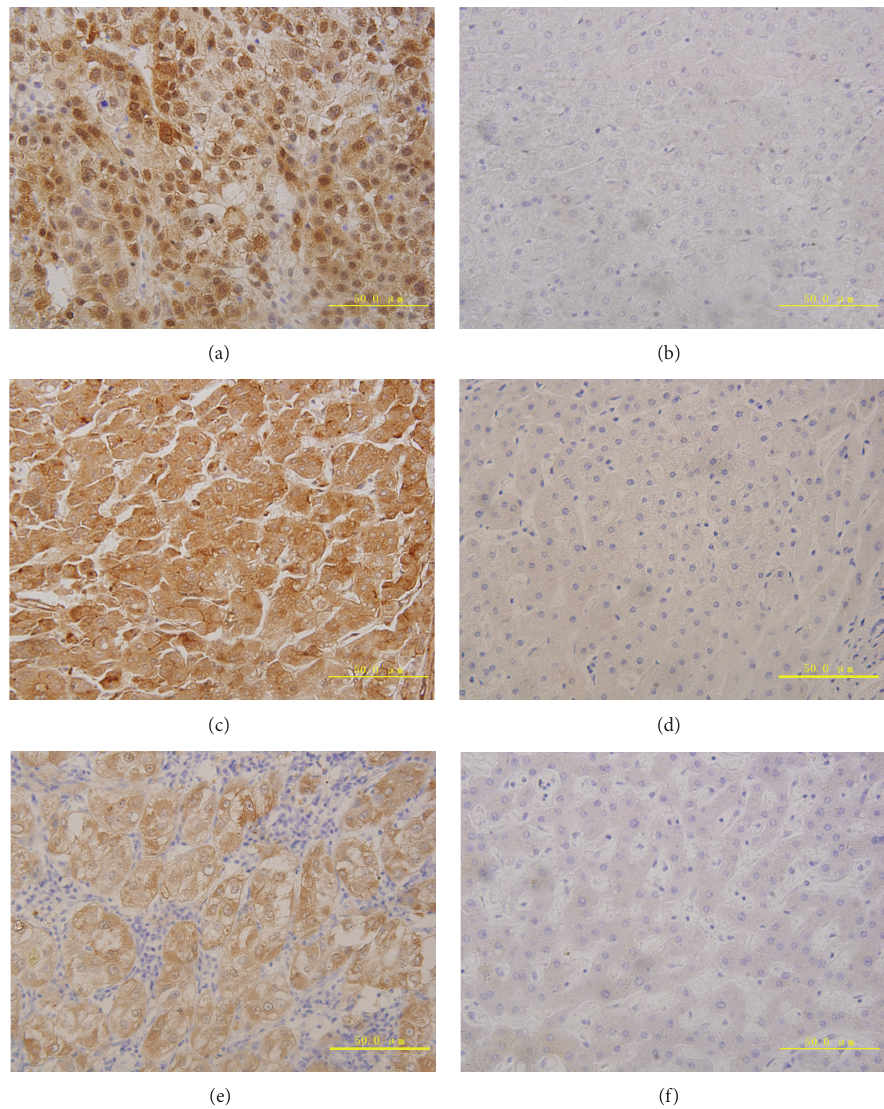
Figure 1: Immunohistochemically stained tissues from HCC patients and adjacent nontumor tissues. Expression of YAP in HCC tissues (a) and adjacent nontumor tissues (b); expression of TAZ in HCC tissues (c) and adjacent nontumor tissues (d); expression of AREG in HCC tissues (e) and adjacent nontumor tissues (f). Representative images were taken under a microscope ( × 400). These results indicate the clinical significance of YAP, TAZ, and AREG overexpression in HCC